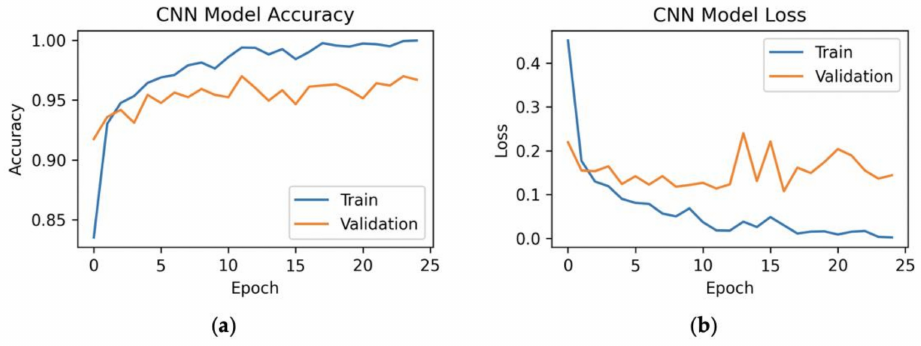
Figure 16. Experimental results for 92 features: ( a ) epoch vs. accuracy and ( b ) epoch vs.